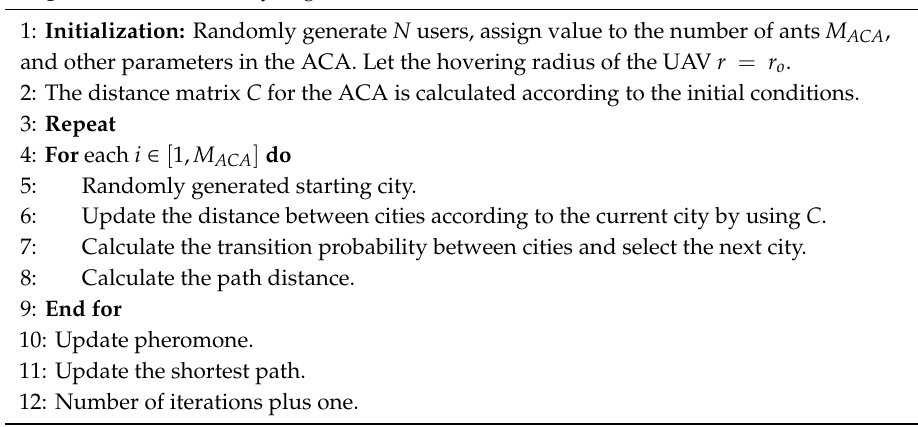
Algorithm 1 : Ant Colony